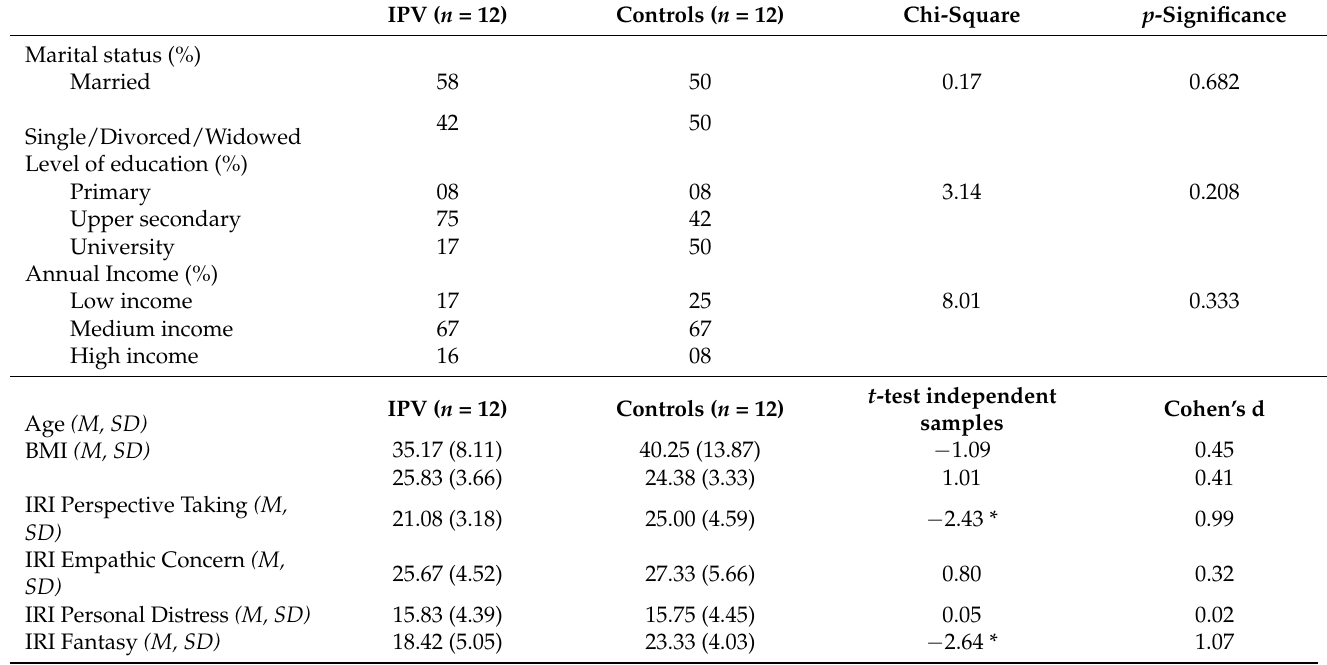
Table 1. Means, standard deviations, percentages, and means comparisons for socio-demographic and psychological variables for all groups.